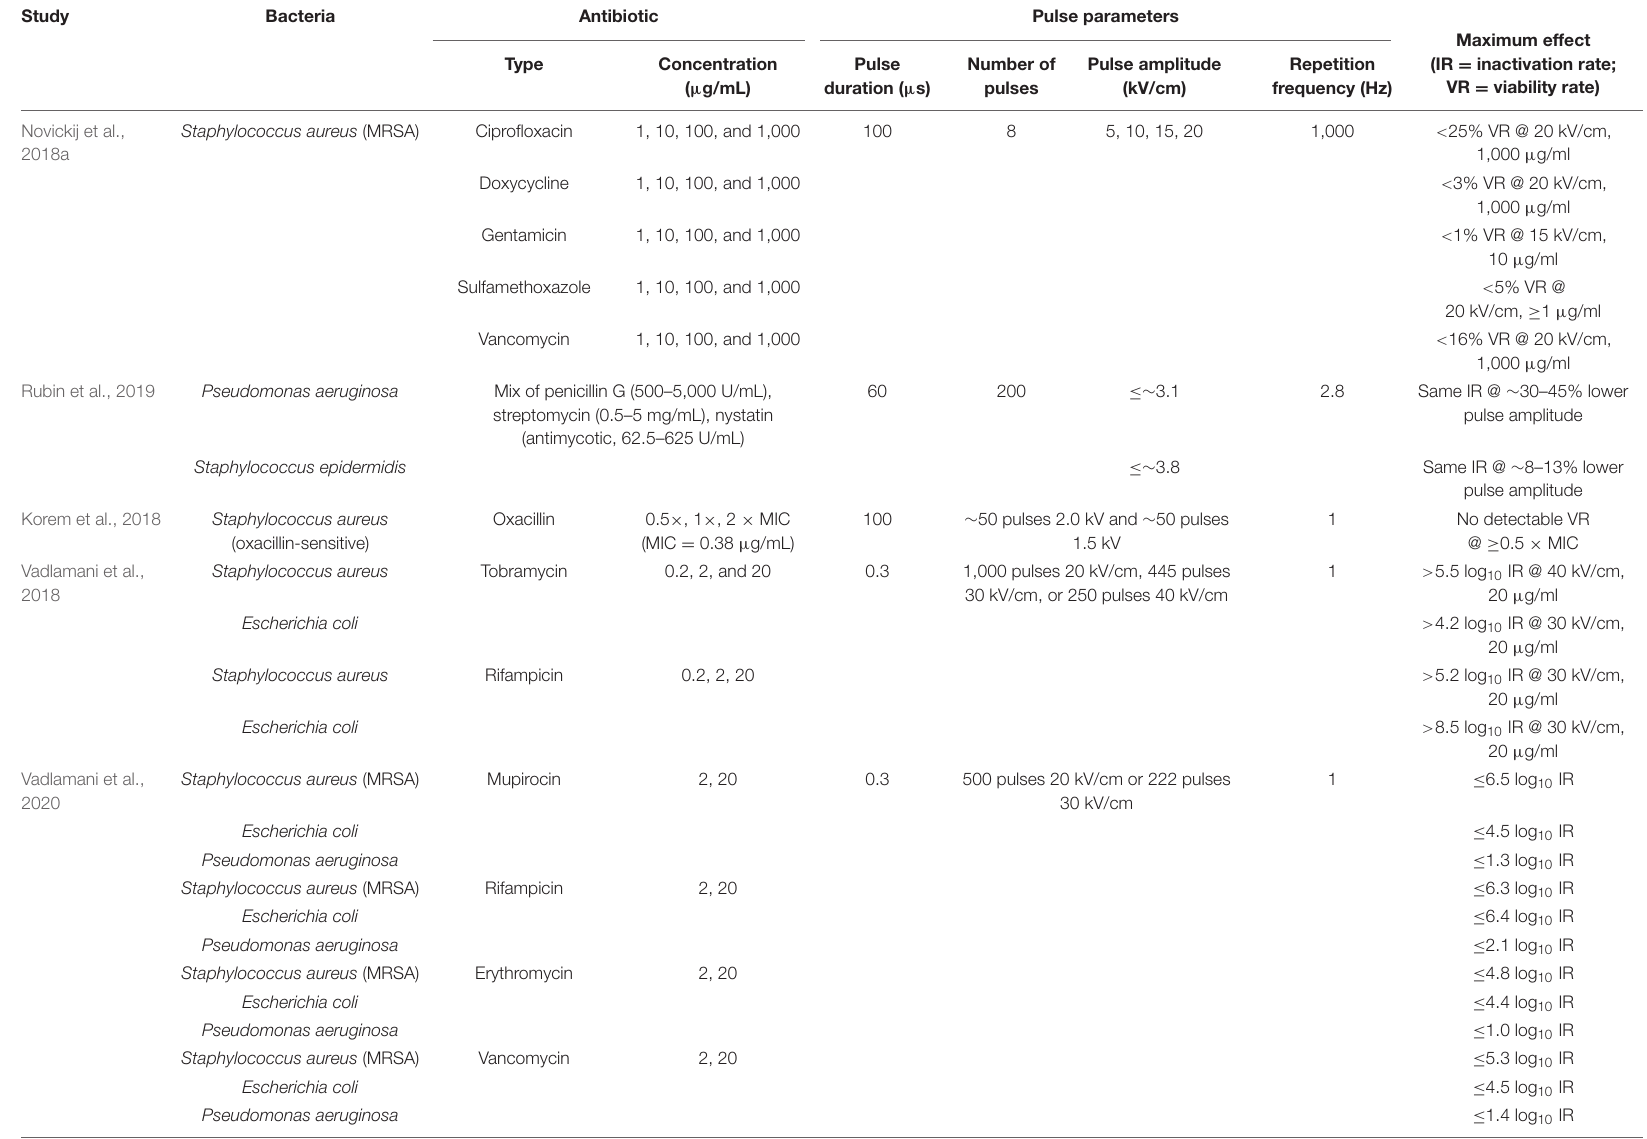
TABLE 1 | Summary of the five reports on combined antibacterial use of clinical antibiotics and electroporation.